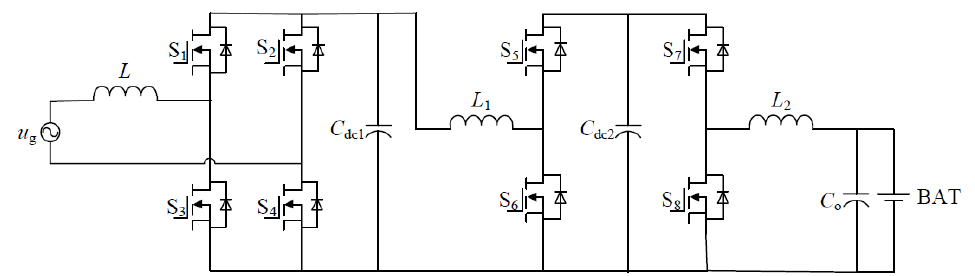
Figure 14. The non-isolated charging topology with PWM and bidirectional cascade DC / DC buck–boost converter.